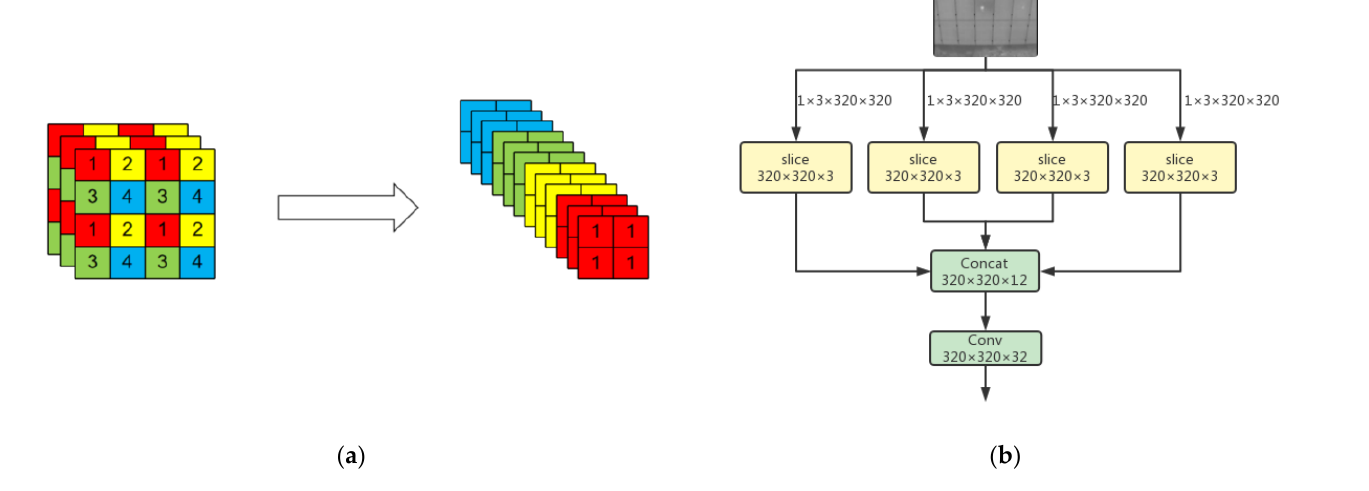
Figure 4. ( a ) Focus slicing process. ( b ) Structure of Focus module. Figure 5a,b show two ShuffleNetv2 basic units. ShuffleNetv2 unit1 splits channels into